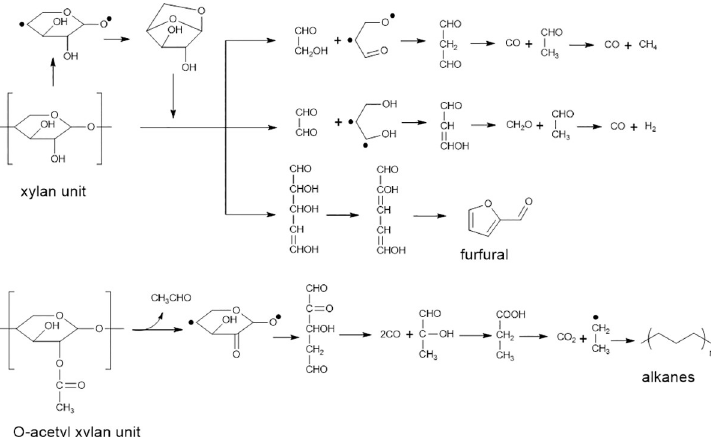
Fig 6. A possible pathway for conversion of hemicelluloses into alkanes, adapted from [46].